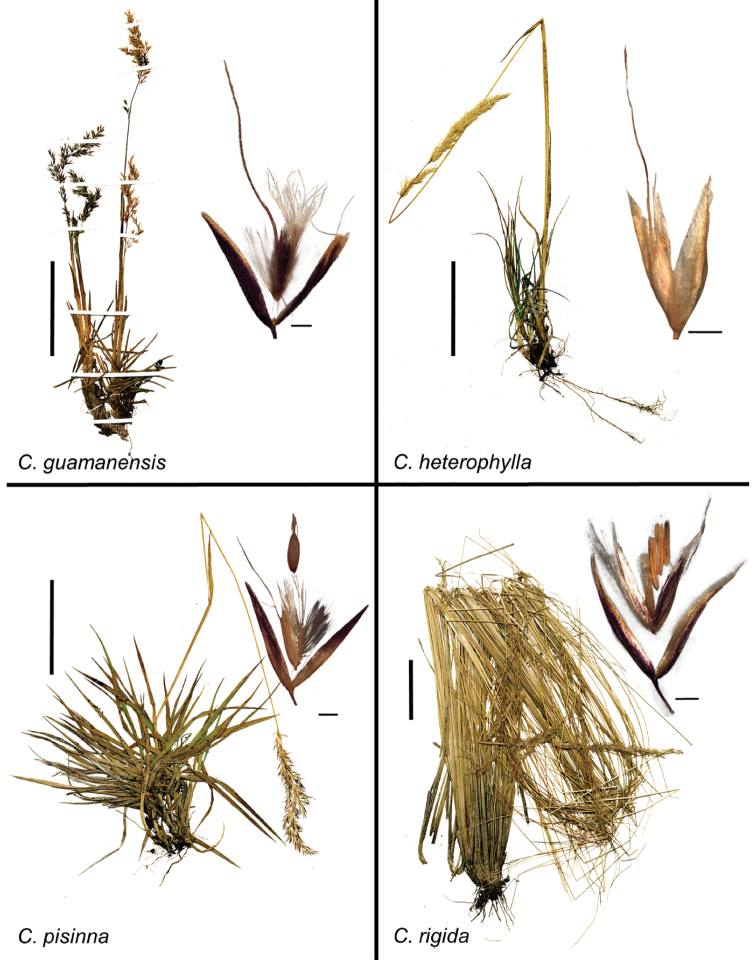
A general habit and a spikelet of Calamagrostisguamanensis Escalona, J.R.I. Wood 4064 (FMB), Calamagrostisheterophylla (Wedd.) Pilg., S.P. Sylvester 3158 (US), Calamagrostispisinna Swallen, S.P. Sylvester 3107 (US), and Calamagrostisrigida (Kunth) Trin. ex Steud., S.P. Sylvester 3125 (US). Habit scale bar 5 cm; spikelet scale bar 1 mm.